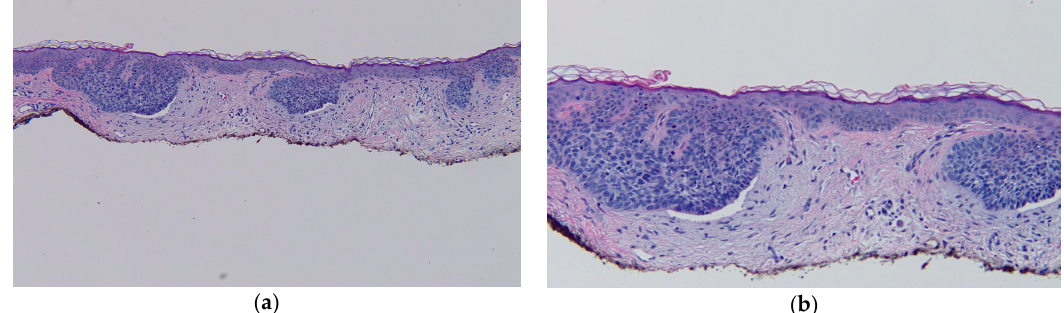
Figure 2. Distant ( a ) and closer ( b ) views demonstrate the microscopic features of the left anterior shoulder superficial basal cell carcinoma. There is orthokeratosis overlying an atrophic epidermis with flattening of the rete ridges. Superficial buds of basaloid tumor cells extend from the epidermis into the papillary dermis. There is palisading of the tumor keratinocytes at the periphery of the aggregates of carcinoma and retraction of the surrounding dermal stroma resulting in cleft formation. There is solar elastosis, small telangiectasias, and a sparse lymphocytic inflammatory infiltrate (hematoxylin and eosin: a, 4×; b, 10×).